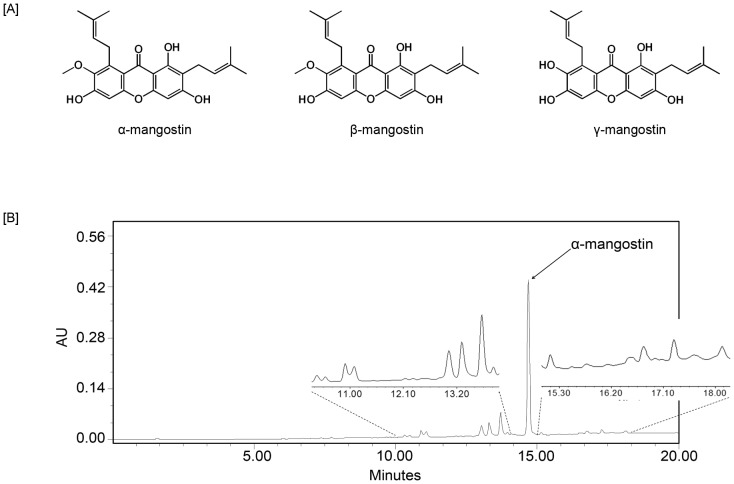
HPLC of Mangosteen fruit extract (MFE).[A], Polyphenolic xanthones isolated from the mangosteen fruit. [B], HPLC Chromatogram of mangosteen fruit extract. Sub-panel represents an expansion of the profile to reveal additional constituents in the extract.